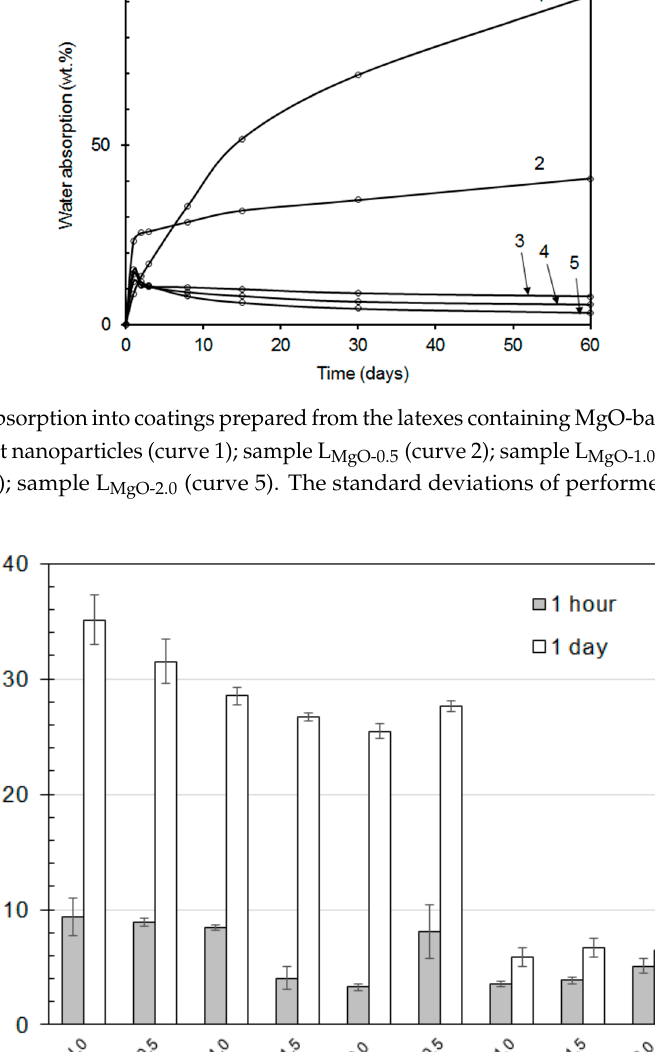
Figure 8. Water absorption into coatings prepared from the latexes containing MgO-based nanoparticles: sample L 0 without nanoparticles (curve 1); sample L MgO-0.5 (curve 2); sample L MgO-1.0 (curve 3); sample L MgO-1.5 (curve 4); sample L MgO-2.0 (curve 5). The standard deviations of performed measurements were below 2%.